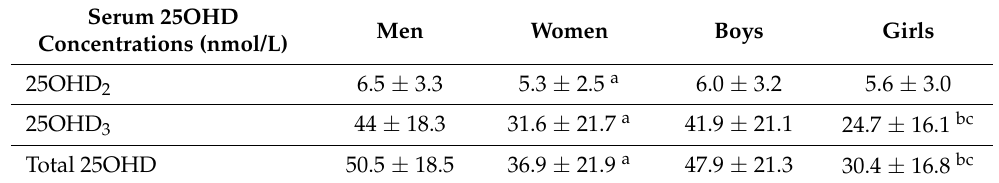
Table 2. Serum 25OHD